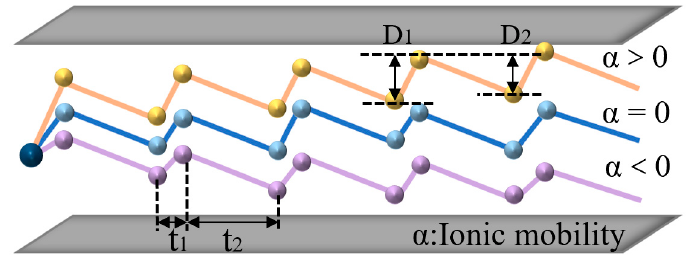
Figure 2. FAIMS ion selection. Figure 2. FAIMS ion